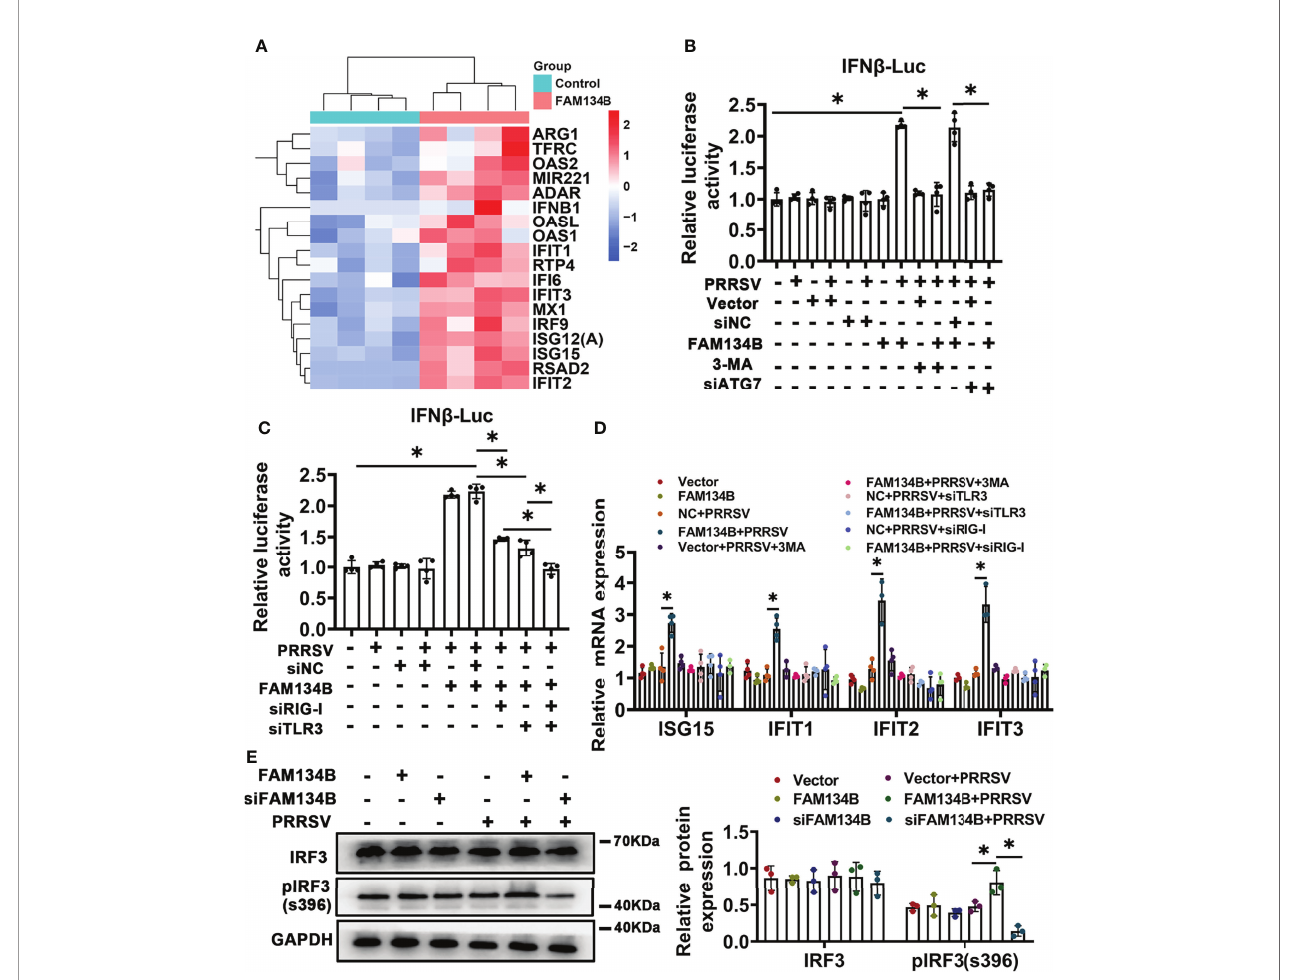
FIGURE 6 | FAM134B activates type I interferon pathway through ER-phagy. (A) Heatmap of differentially expressed genes (DEGs) by RNA-seq. (B, C) Promoter luciferase activity of IFN b by double luciferase reporting system. * P <0.05, Wilcox test, n=4. (D) mRNA expression of ISG15, IFIT1, IFIT2 and IFIT3 in PK15 CD163 cells. * P <0.05, Kruskal Wallis test, n=3 or 4. (E) Expression of IRF3 and pIRF3(s396) in PK15 CD163 cells. * P <0.05, Kruskal Wallis test, n=3. GAPDH served as the